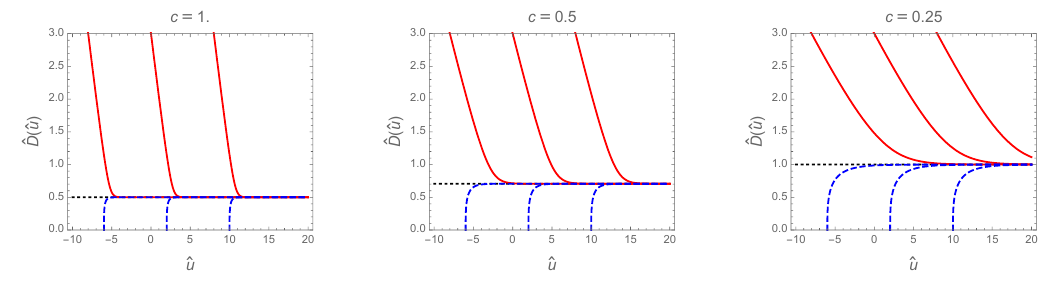
Figure 2 . The three classes of solutions for the function ^ D (^ u ), with positive c , and for (cid:15) = +1. Therefore, u is a retarded null coordinate. Di(cid:11)erent panels display the solutions for three choices of c , namely c = 1 ; 1 = 2, and 1 = 4. Class A solutions are represented with solid (red) curves, class B in dashed (blue) lines, and the class C solution is the horizontal dotted (black) line. Solutions within each family di(cid:11)er only by a shift in ^ u .